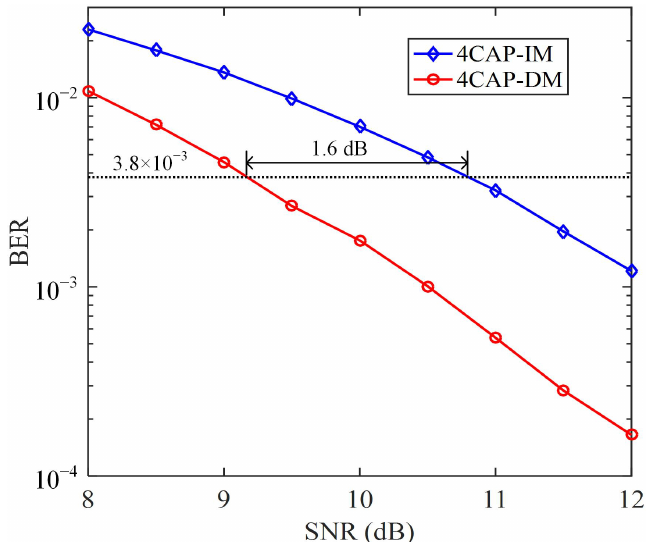
Figure 3. Simulation BER vs. SNR for 4CAP-IM and 4CAP-DM achieving the same SE of 2.5 bits/s/Hz over the AWGN channel.